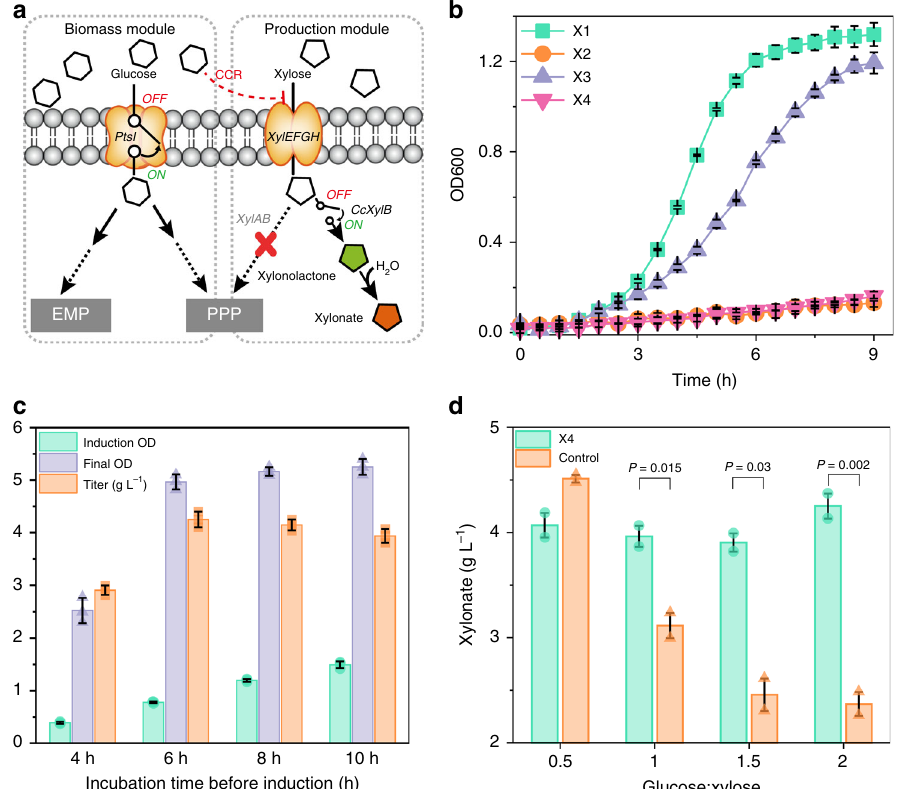
Fig. 6 Application of pbI in D -xylonate production. a D -Xylonate metabolic pathways in E. coli with pbI. Red cross denotes gene disruption. b Growth curve of different strains in NBS minimal medium with glucose as carbon source (0.05 mM IPTG was pre-added to the medium of strain X3; 0.05 mM IPTG and 100 ng mL − 1 ATC was pre-added to the medium of strain X4). Data point indicates the mean values from three parallel samples in 96-microplate at 37 °C. c Induction time evaluation of strain X4. Values are shown as mean ± SD ( n = 3). d Titer comparison of control strain (wild-type strain with D -xylose dehydrogenase overexpression) and X4 strain. Anhydrotetracycline (200 ng mL − 1 ) was added at exponential growth period (6 h). Values are shown as mean ± SD ( n = 2). Signi fi cance ( p -value) was evaluated by two-sided t -test. CCR, carbon catabolite repression; CcxylB, Caulobacter crescentus D -xylose dehydrogenase; EMP, embden-meyerhof-parnas pathway; PPP, pentose phosphate pathway; PtsI, phosphotransferase enzyme I; XylA, xylose isomerase; XylB, xylulose kinase; XylEFGH, xylose transport proteins. Source data of Fig. 6b – d are provided in Source Data fi